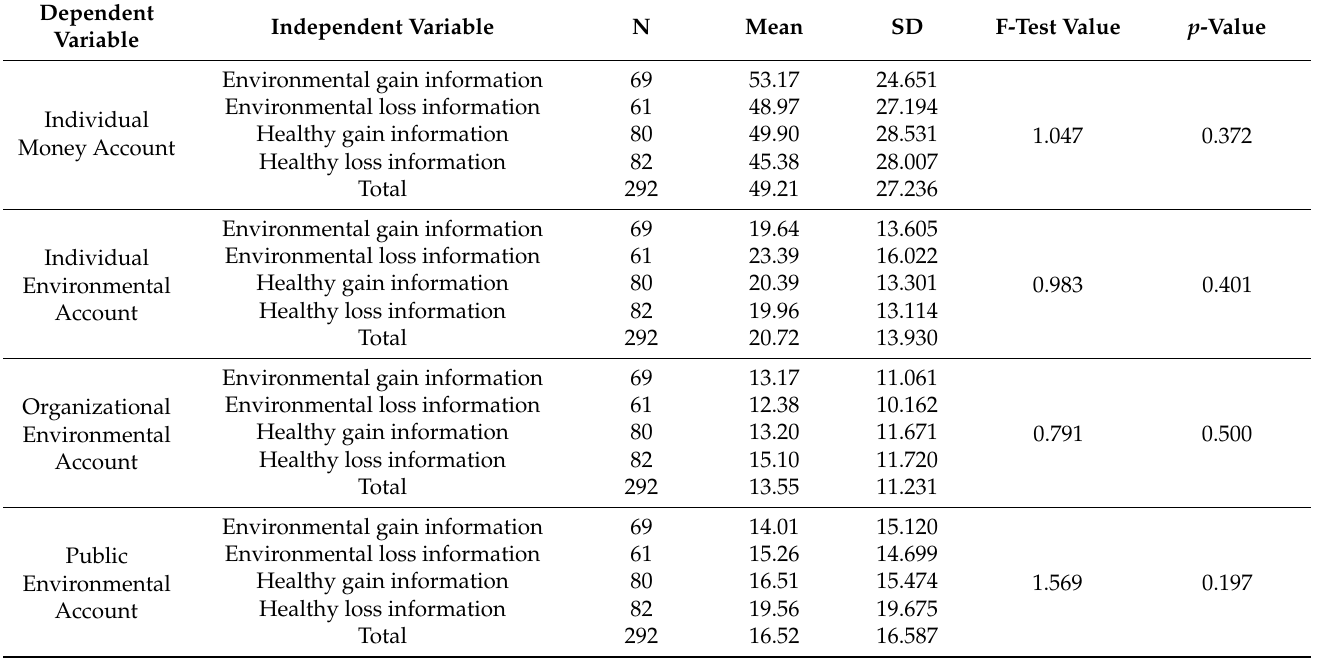
Table 4. Between-group difference test for initial point allocation for participants in the four pre-test groups.